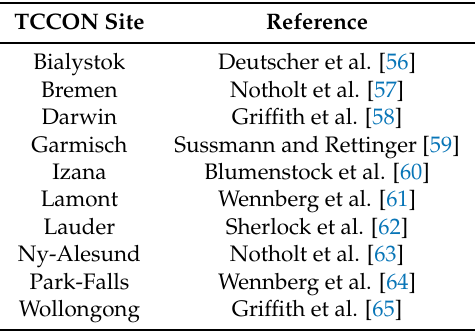
Table B1. TCCON sites with references to the data used in this